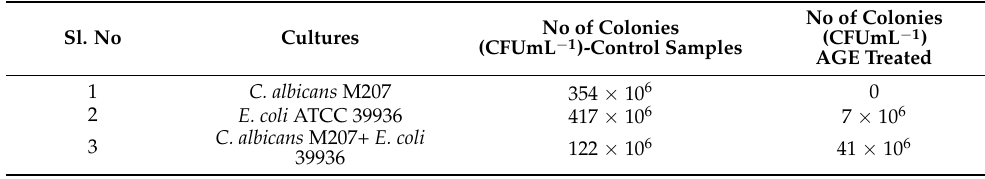
Table 2. CFU count on agar surface.